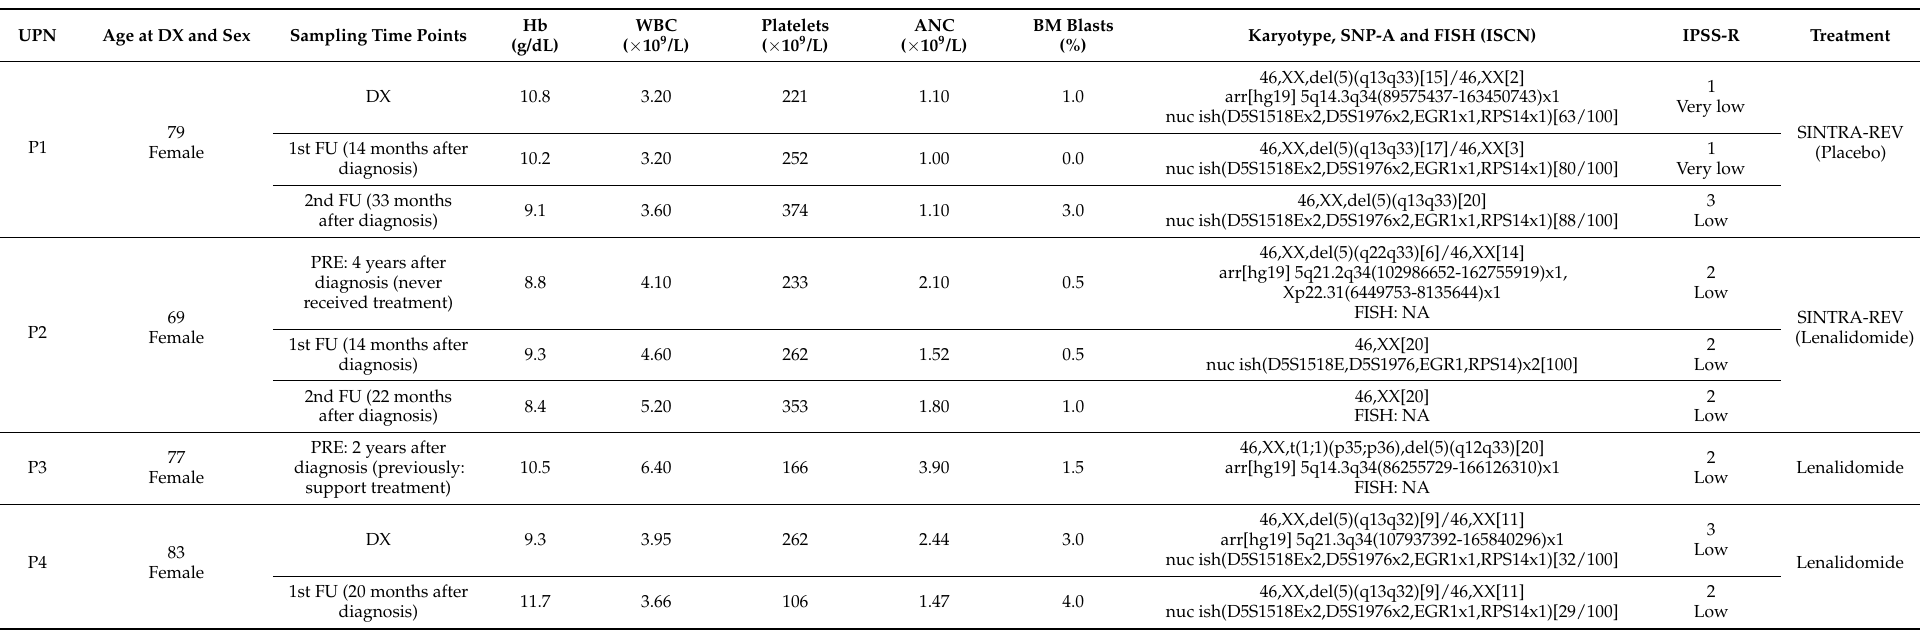
FISH: XL 5q31/5q33/5p15 locus-specific deletion probe was used to detect 5q deletions (D-5081-100-TC, MetaSystems Probes). SINTRA-REV: phase III multicenter, randomized, double blind and controlled with placebo clinical trial and with two arms designed to assess the efficiency and toxicity of the scheme Lenalidomide versus observation in a series of 60 patients with low risk myelodysplastic syndrome associated to 5q deletion with anemia (Hb ≤ 12 g/dL) but without the need of transfusion. Abbreviations: ANC: absolute neutrophil count; BM: bone marrow; DX: diagnosis; FISH: fluorescence in situ hybridization; FU: follow-up; Hb: hemoglobin; IPSS-R: Revised International Prognostic Scoring System; NA: not available; PRE: pre-treatment; SNP-A: single nucleotide polymorphism arrays; UPN: unique patient number; WBC: white blood